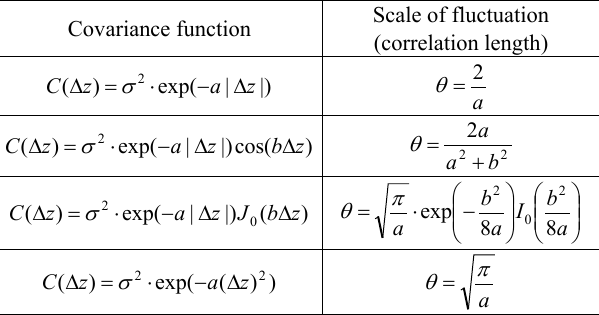
Table 7. Covariance functions and scales of